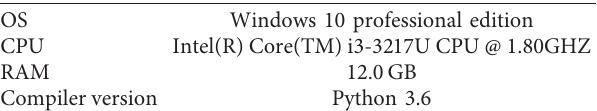
Table 2: Execution